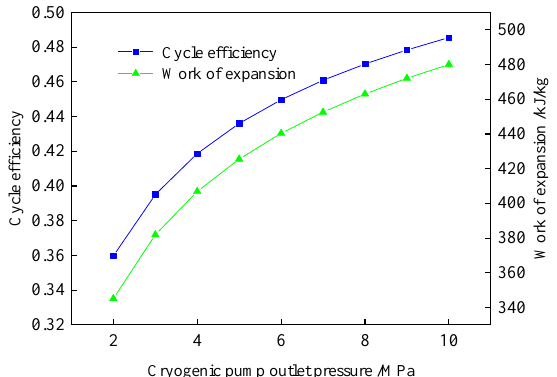
Figure 3. Influence of the outlet pressure of the cryogenic pump on the expansion work and the cycle